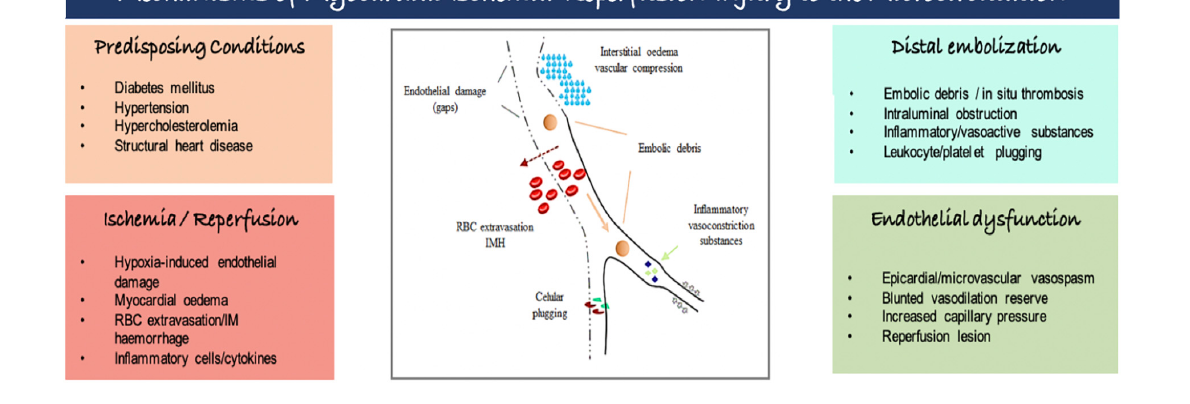
FIGURE2 Mechanisms of myocardial ischemia-reperfusion injury to the microcirculation. IM, intramyocardial; RBC, red blood